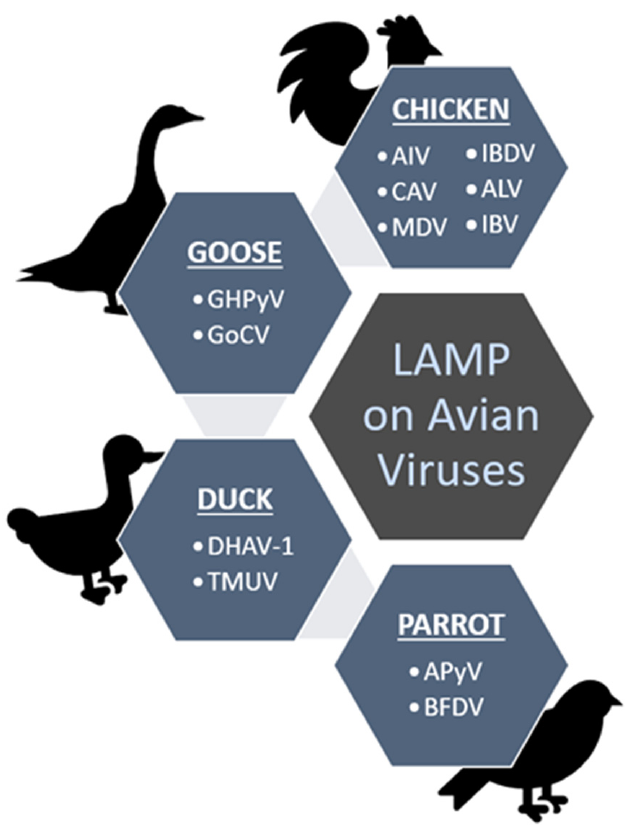
Figure 3. Summary of the discussed avian viruses that have been screened from chickens, geese, ducks and parrots using the established LAMP methods.